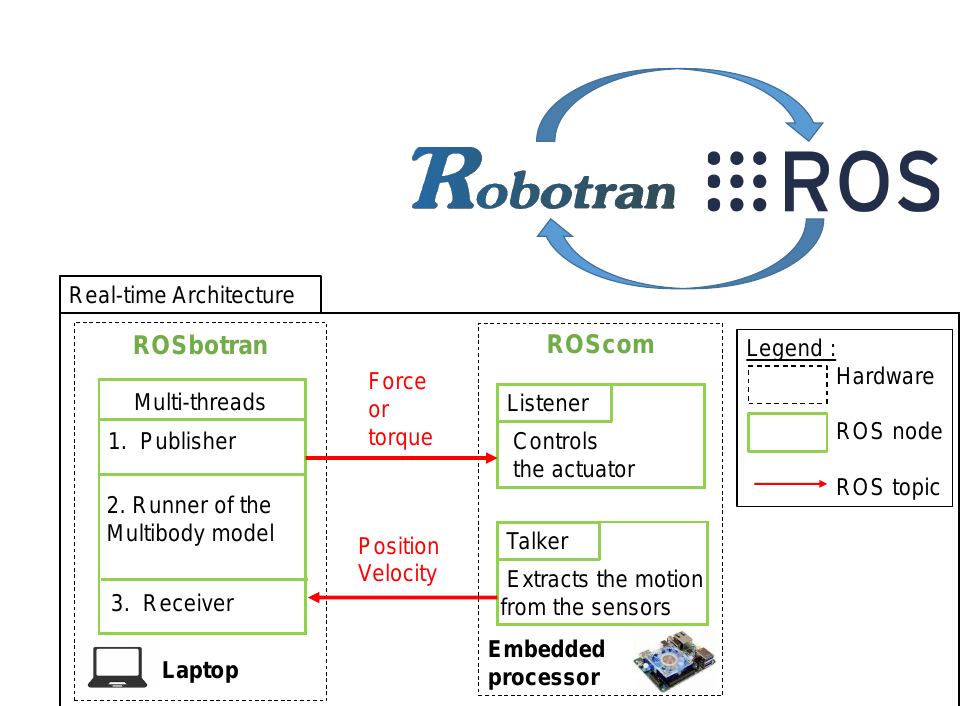
Figure 8. Software architecture with ROS and